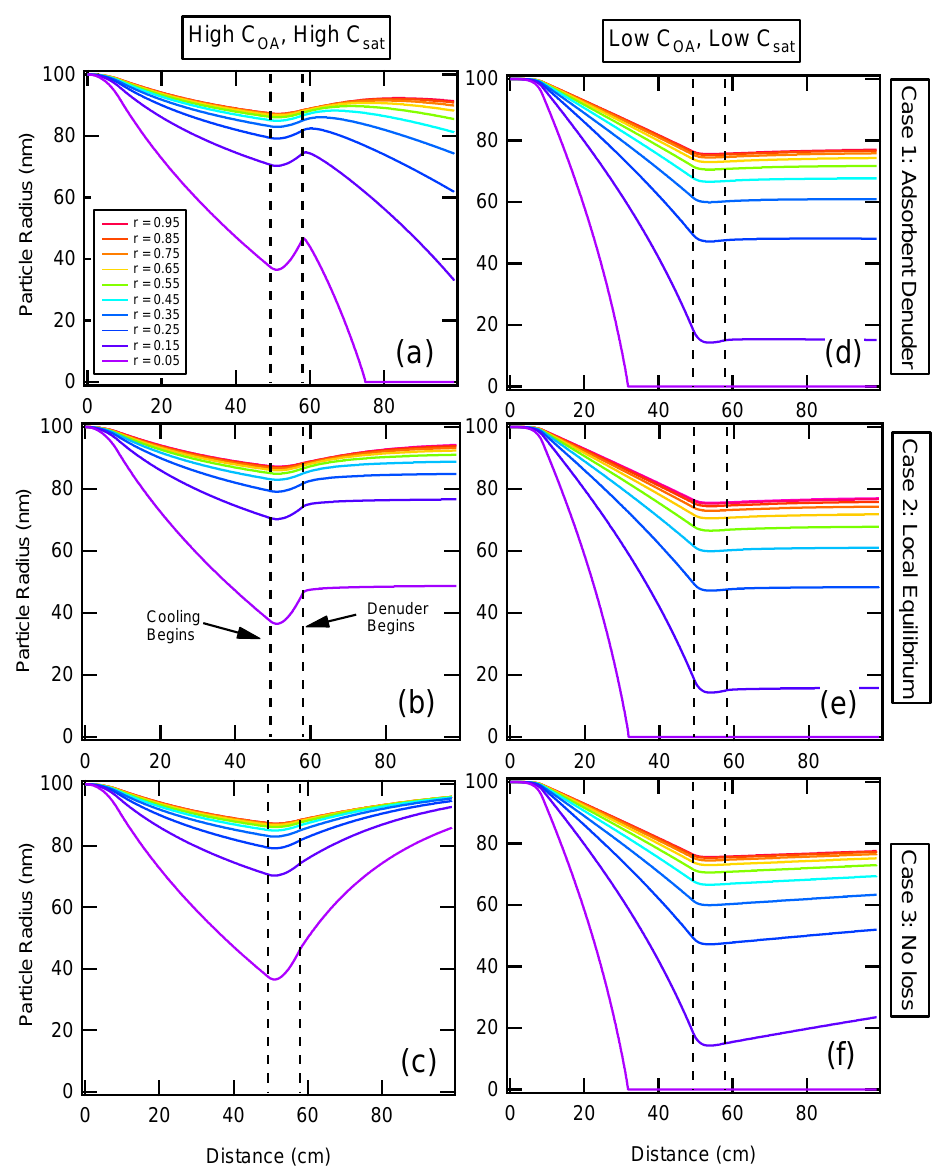
Fig. 6. The modeled variation in particle radius is shown as a function of the distance along the thermodenuder. The different curves in each panel correspond to particles that are closer to/further from the thermodenuder walls (line colors indicate the relative distance of that bin from the wall). Panels aligned vertically are for the same C sat while panels aligned horizontally have the same denuder boundary condition. The left panels ( a , b and c ) are for C sat (25 ◦ C)=100µg/m 3 at T d =35 ◦ C, C OA =150µg/m 3 and 1H vap 60kJ/mol while the right panels ( d , e and f ) are for C sat (25 ◦ C)=1µg/m 3 at 60 ◦ C, C OA =15µg/m 3 and 1H vap 120kJ/mol. The top panels (a and d) correspond to the adsorbent denuder (Case 1), the middle panels (b and e) to the local equilibrium (Case 2) and the bottom panels (c and f) to no loss (Case 3). In all cases t res =15s and γ e =1. The vertical dashed lines indicate the point where the cooling begins (left) and the denuder section begins